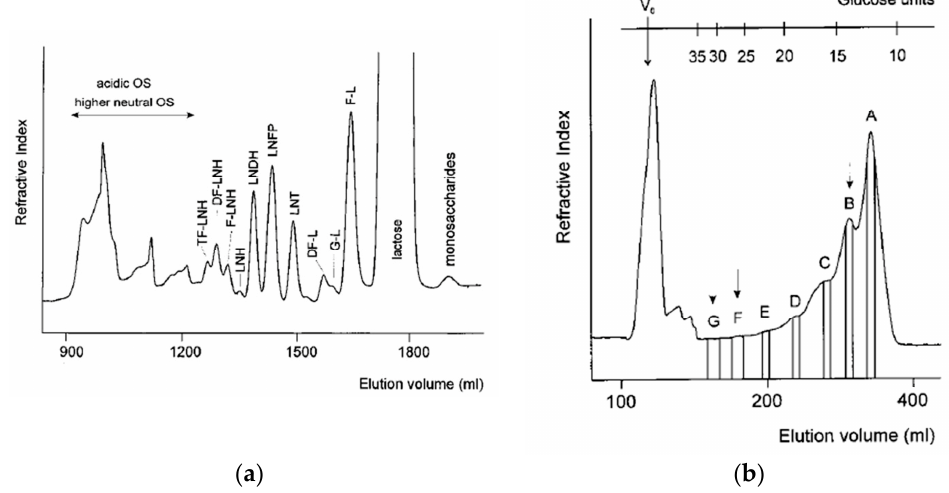
Figure 6. Examples of gel filtration chromatographies of human milk oligosaccharides (HMOs). Elution was monitored wit RI detection. ( a ) Gel filtration elution profile on Toyopearl HW 40 (S) column of the total carbohydrate fraction from human milk. ( b ) Gel filtration elution profile on a Bio-Gel P-6 column of the HW 40 (S) subfraction of the neutral carbohydrate fraction. Reproduced with permission from [46]. Copyright American Chemical Society, 1999.